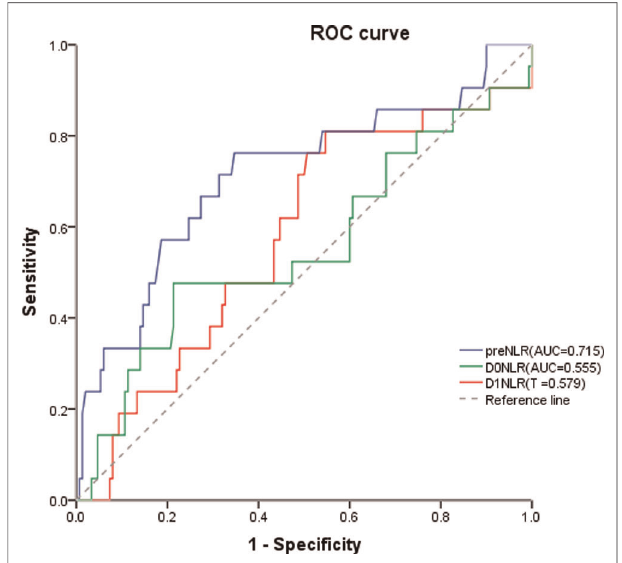
FIGURE 1 | The preNLR showed the greatest discriminatory ability with an AUC of 0.72 (95% con fi dence interval 0.583 – 0.846, p =0.001). A preNLR cutoff value of 2.30 was identi fi ed as having the greatest ability to predict complications with a sensitivity of 76% and speci fi city of 65% preNLR, pre- operative neutrophil to lymhocyte ratio; DONLR, the day of surgery neutrophil to lymhocyte ratio; DINLR, the fi rst day after surgery neutrophil to lymphocyte